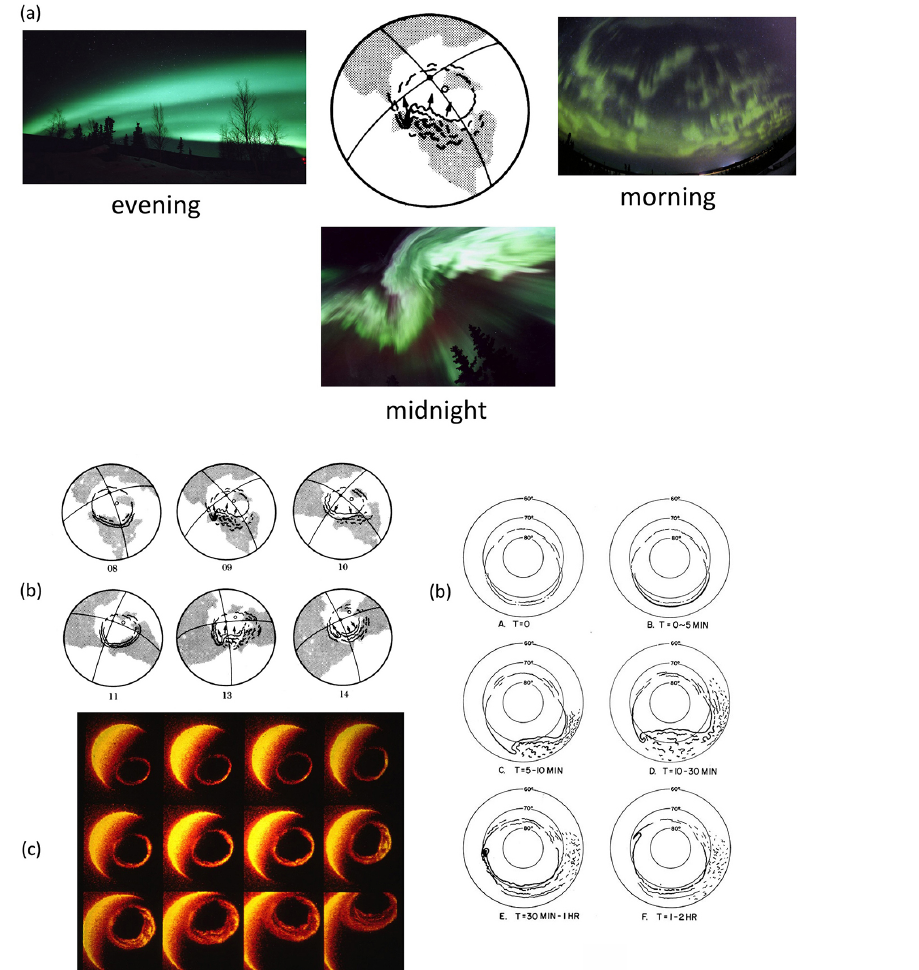
Figure 5. (a) The fixed pattern of auroral activities. In the evening sector, the aurora is relatively quiet, very active in the midnight sector and patchy in the morning sector. The earth rotates under such a pattern once a night. (b) The concept of auroral substorms is schematically shown. (c) The first image of a full development of an auroral substorm (Frank et al.,